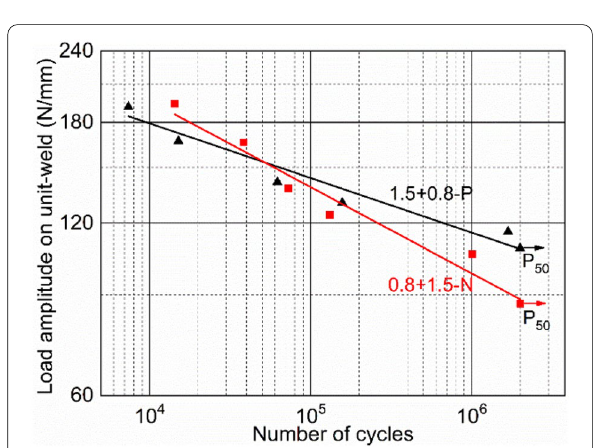
Figure 6 S-N curves of penetration 1.5 0.8 1.5-N +